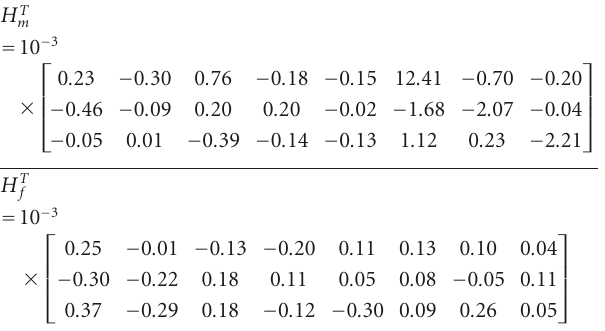
Table 6: The calculated mixing matrices for the maternal and fetal dipole vectors. H T